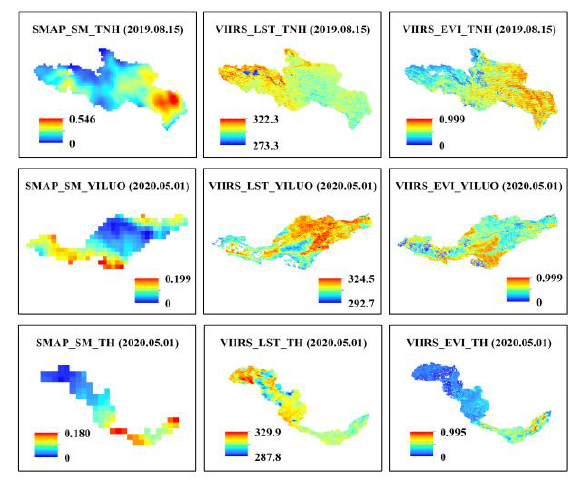
Figure 2. SMAP soil moisture and VIIRS LST/EVI for the three test areas — TNH (short for Tangnaihai River basin), YILUO (short for Yiluo River basin), and TH (short for Tanghe River basin) on 2019.08.15 and 2020.05.01.